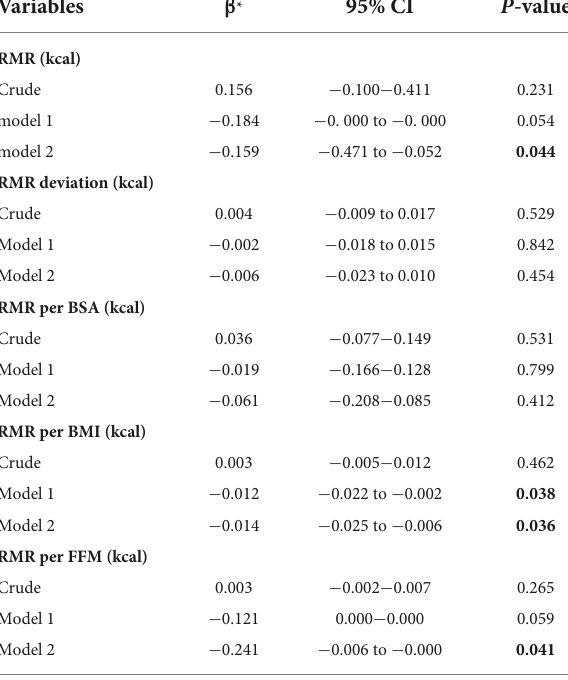
TABLE 5 The association of the mediating effect of inflammatory markers on RMR subcategories between UPF tertiles in overweight and obese